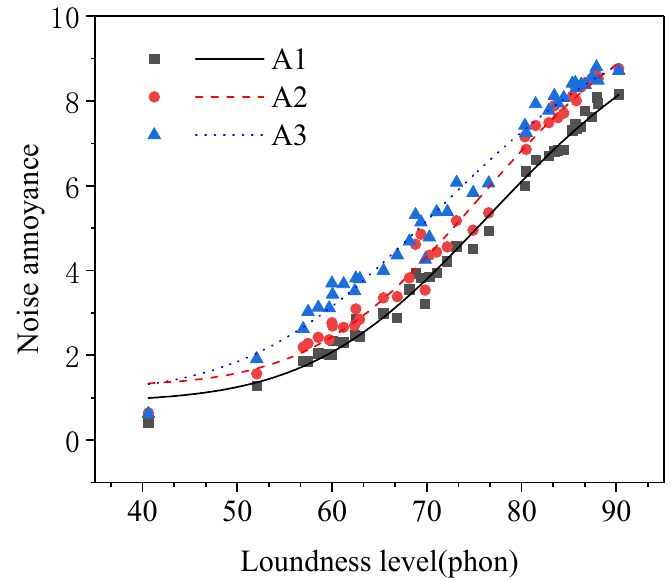
Figure 3. Noise annoyance of three groups of subjects with different ages (subgroups A1–A3).